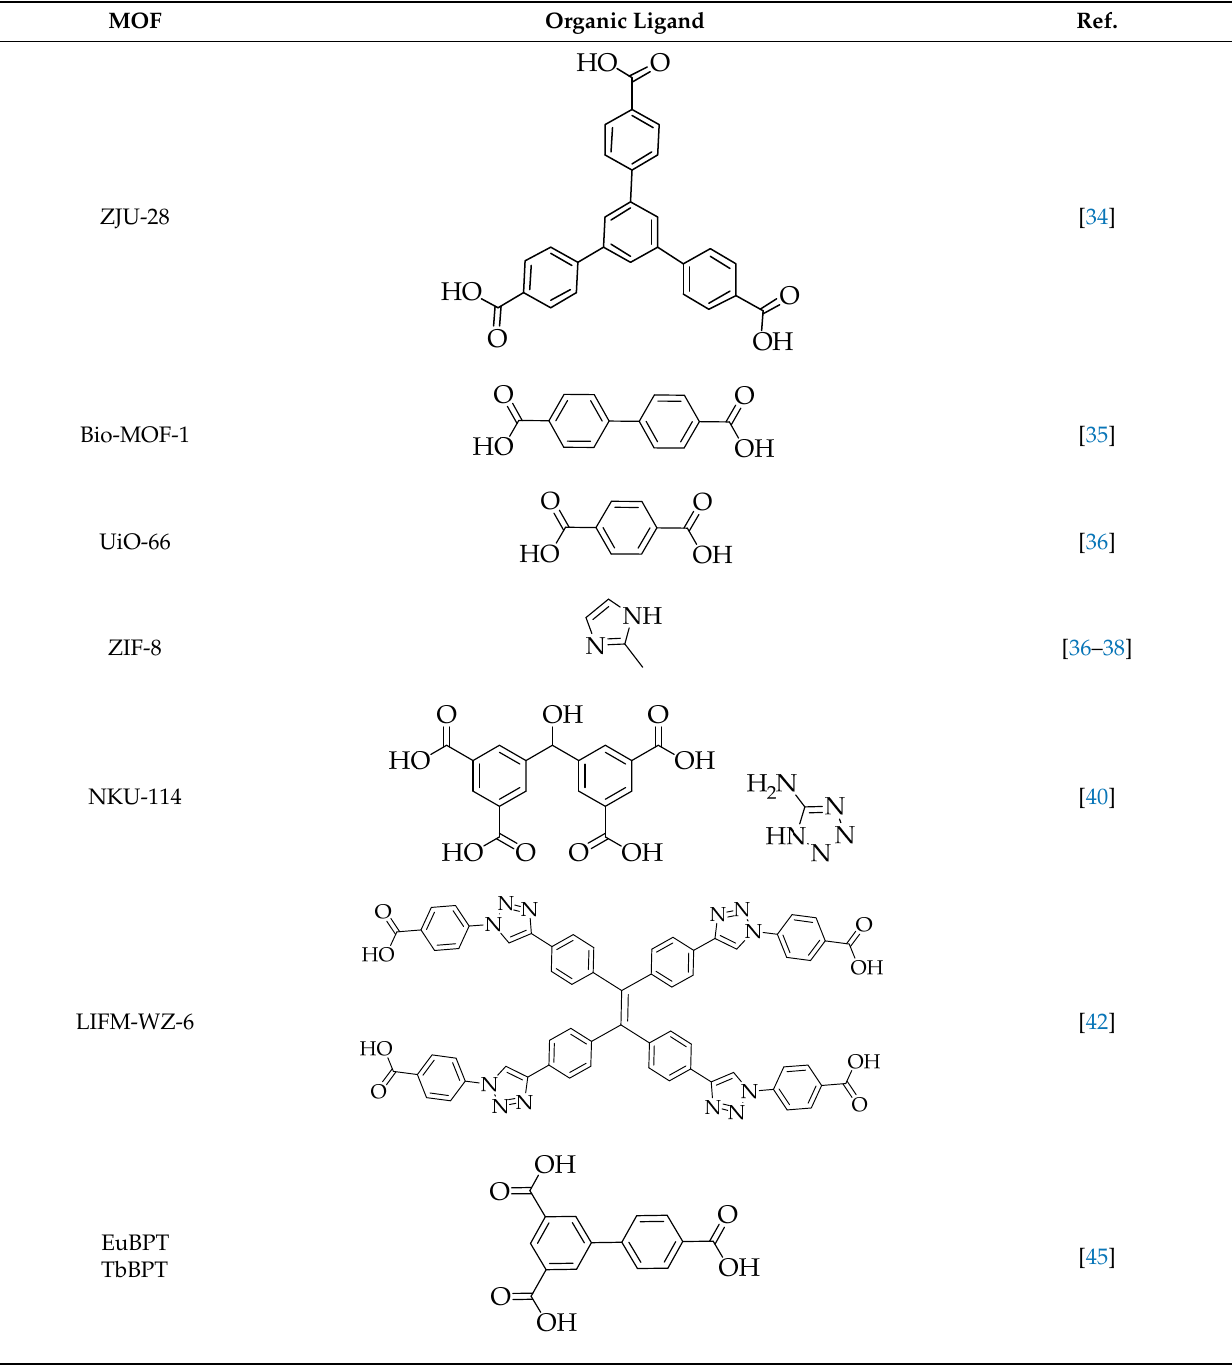
Table 1. Structural information about organic ligands of MOFs. Organic Ligand Ref. Organic Ligand